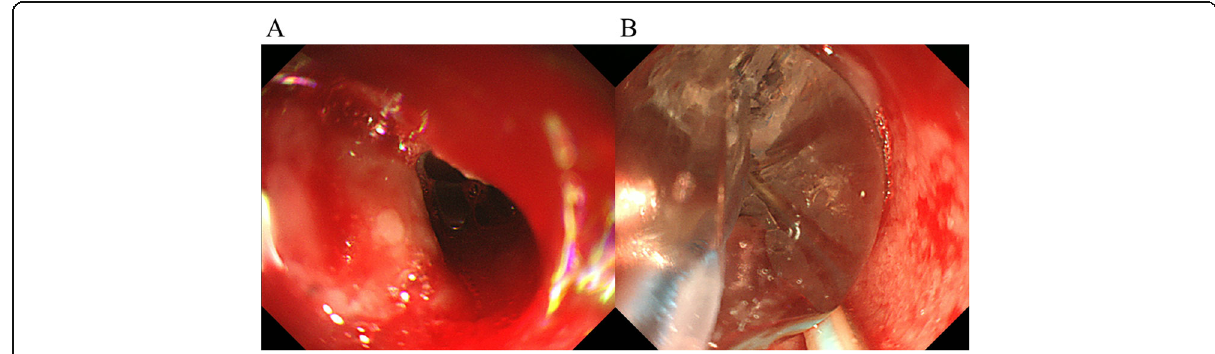
Fig. 1 a Endoscopic examination confirmed the presence of anastomotic stenosis. b Endoscopic balloon bougie was performed on the 58th POD